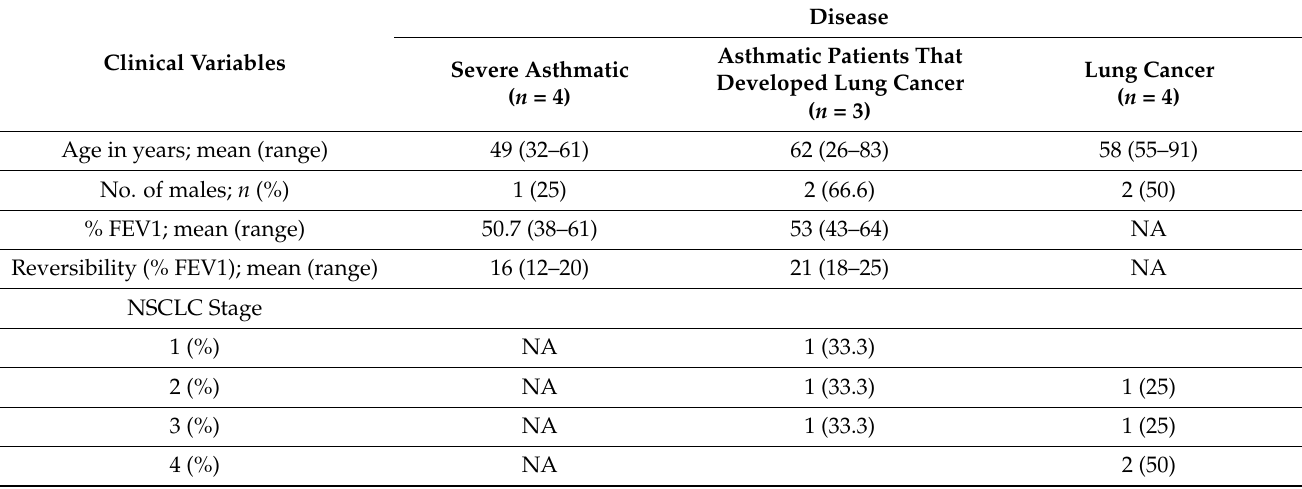
Table 2. Clinical characteristics of patients whose tissues were collected for FFPE blocks.